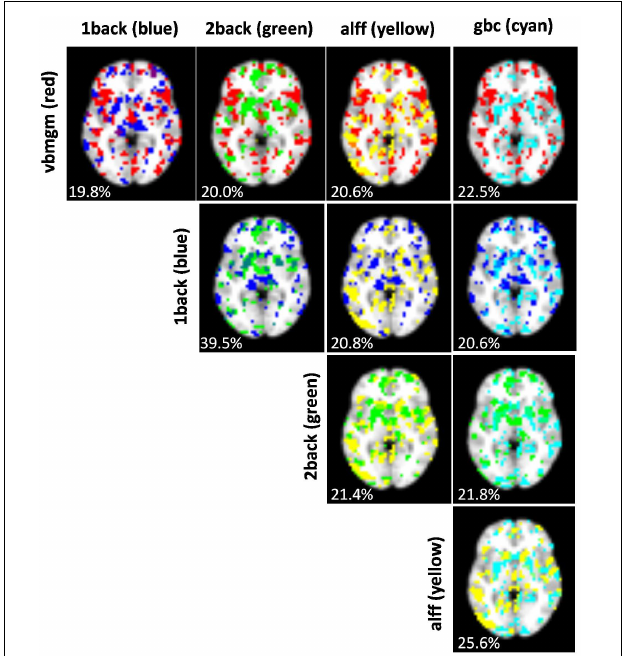
FIGURE 6 | Accuracies achieved by the best-performing algorithm in the unimodal setting and for the three multimodal integrative strategies, namely, unimodal Lasso applied to the 2back maps, the mean of the output probabilities from Ridge (which performed equally well as the maximum probability algorithm), the two-step sequential Ridge algorithm, and the one-dimensional convolutional neural network. Continuous line, mean accuracies; gray dashed lines, 95% bootstrap intervals of mean accuracies; gray doted lines, maximum and minimum accuracies delivered by the 10-fold